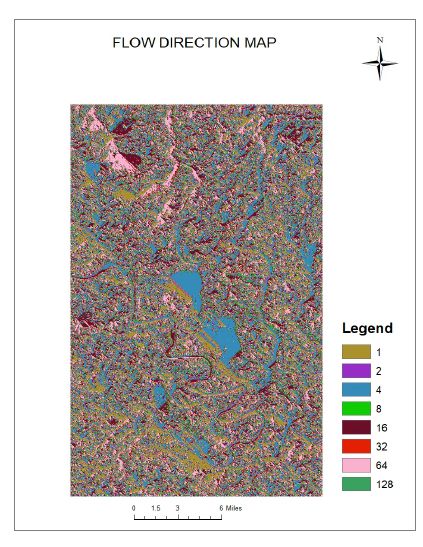
Figure.4. Flow Direction Map